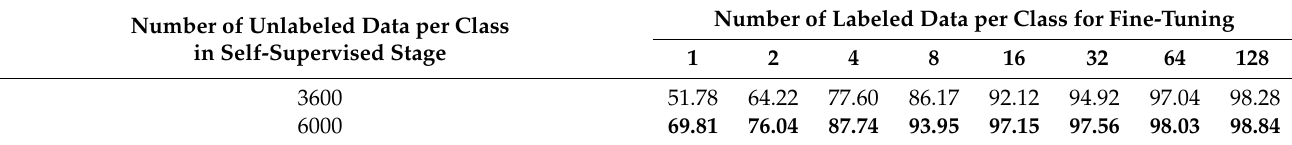
Table 5. The test accuracy (%) of the MsvNetLite with different numbers of unlabeled data per class in the self-supervised stage. The bold number is the best result in each column. Number of Unlabeled Data per Class in Self-Supervised Stage